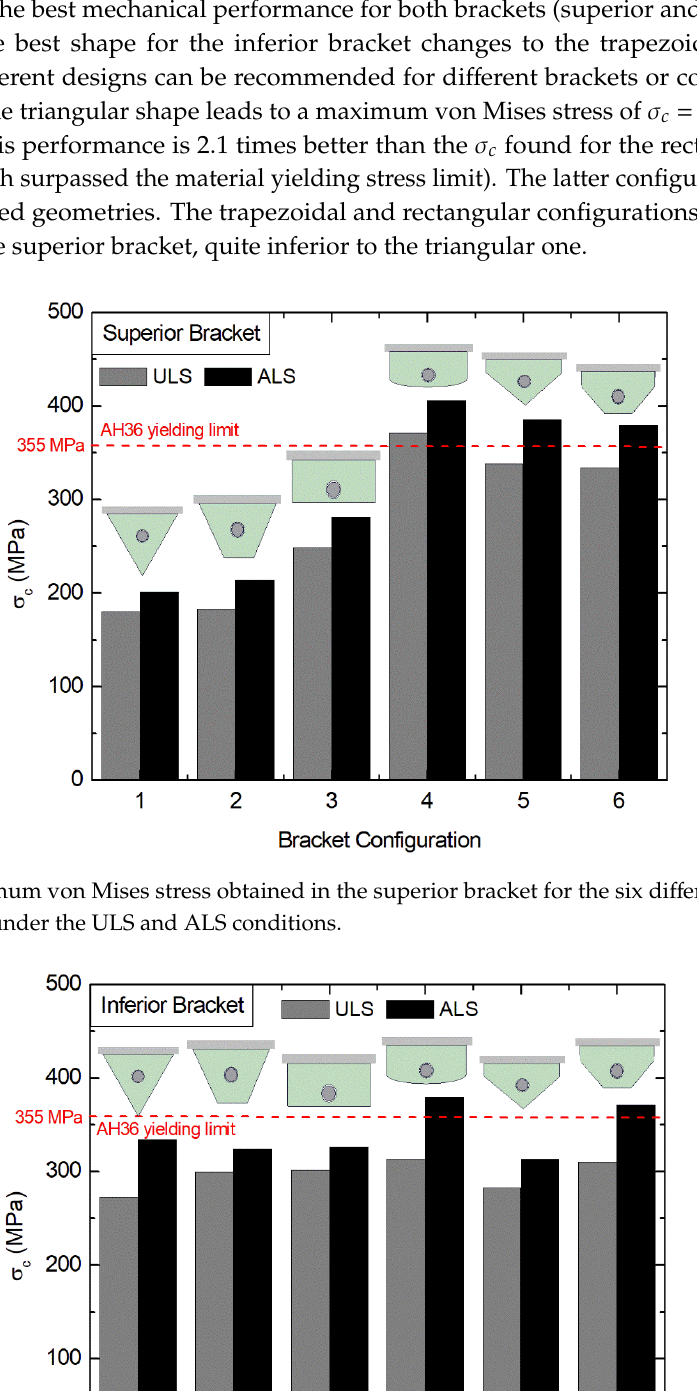
Figure 11. Distribution of the von Mises stress (in MPa) for the triangular shape of the superior bracket under ULS conditions: ( a ) superior view and ( b ) inferior view.